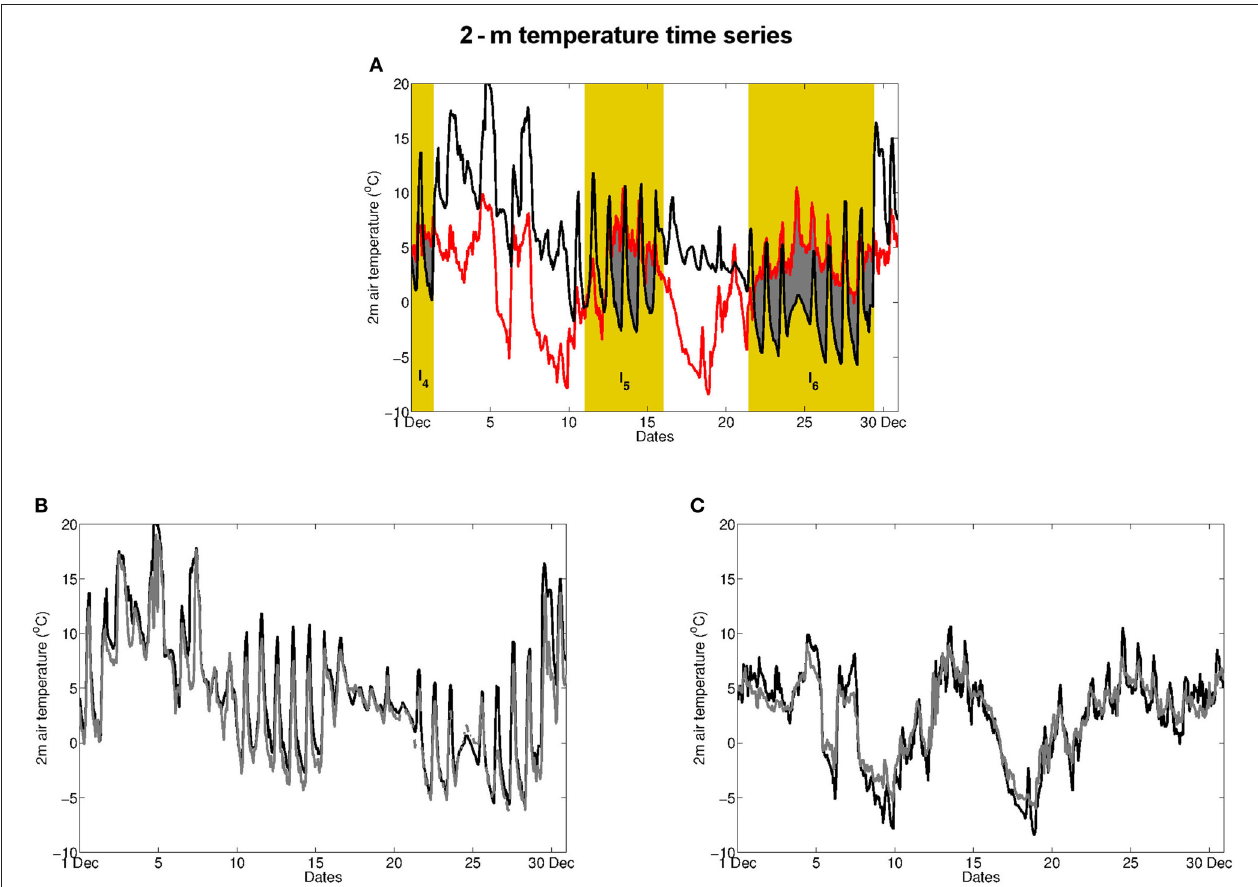
FIGURE 2 | Time series of 2-m air temperature in December 2006 at (A) the low-elevation station of LV (black) and the high-elevation station of CR (red). The gray-shaded zones refer to temperature inversions (the temperature in CR is higher than in LV); persistent inversions defined by criterion (1) are indicated by a yellow veil; (B) two low-elevation stations, LV (black) and POC (gray); (C) two high-elevation stations, CR (black) and LG